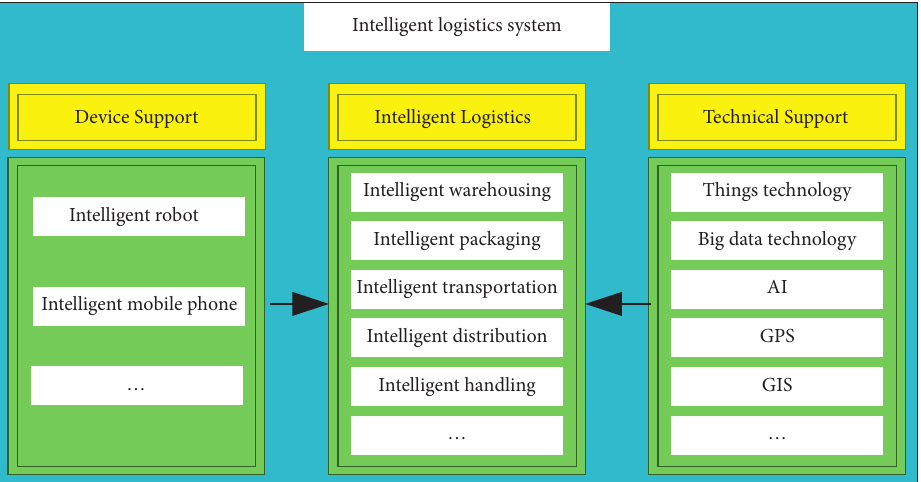
Figure 2: Intelligent logistics system.